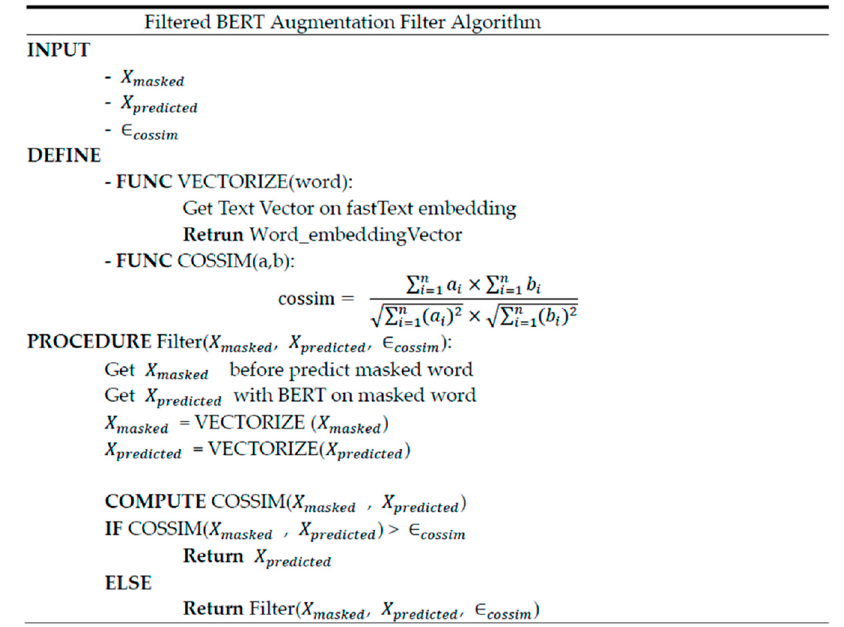
Figure 3. Filter